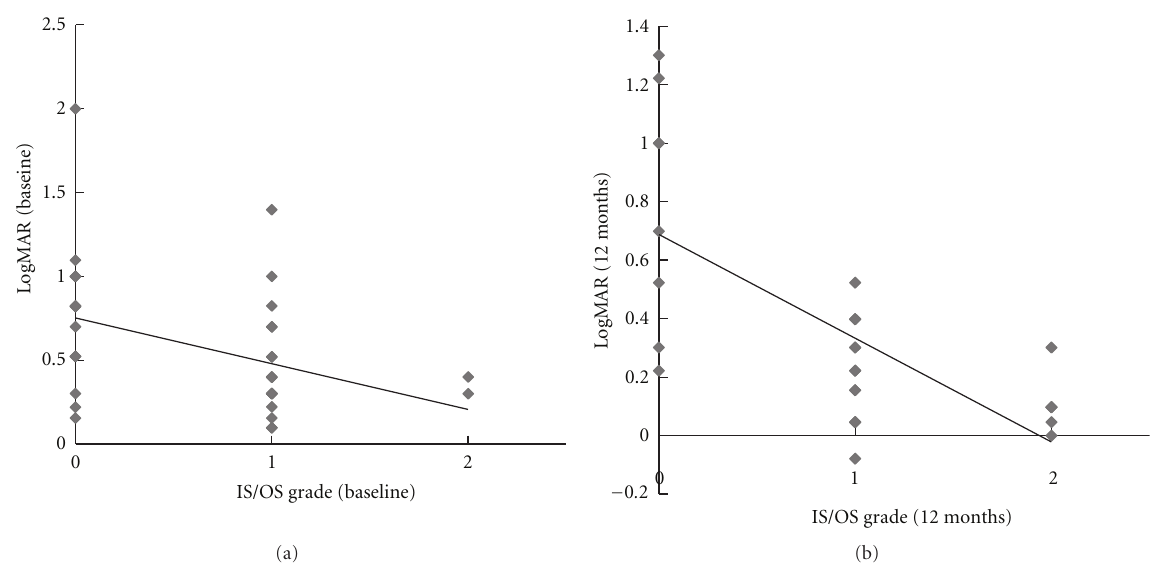
Figure 3: Scatter plots showing correlations between visual acuity and grades of the inner and outer segments of the photoreceptors (IS/OS). Visual acuity was expressed as the logarithm of minimal angle of resolution (logMAR). (a) Scatter plot at baseline. There was a significant negative correlation between visual acuity at baseline and IS/OS grade at baseline (Speaman correlation coe ffi cient [ r s ] = − 0 . 429; P < 0 . 01). (b) Scatter plot at 12 months. There was a significant negative correlation between visual acuity at 12 months and IS/OS grade at 12months ( r s = − 0 . 687; P < 0 .